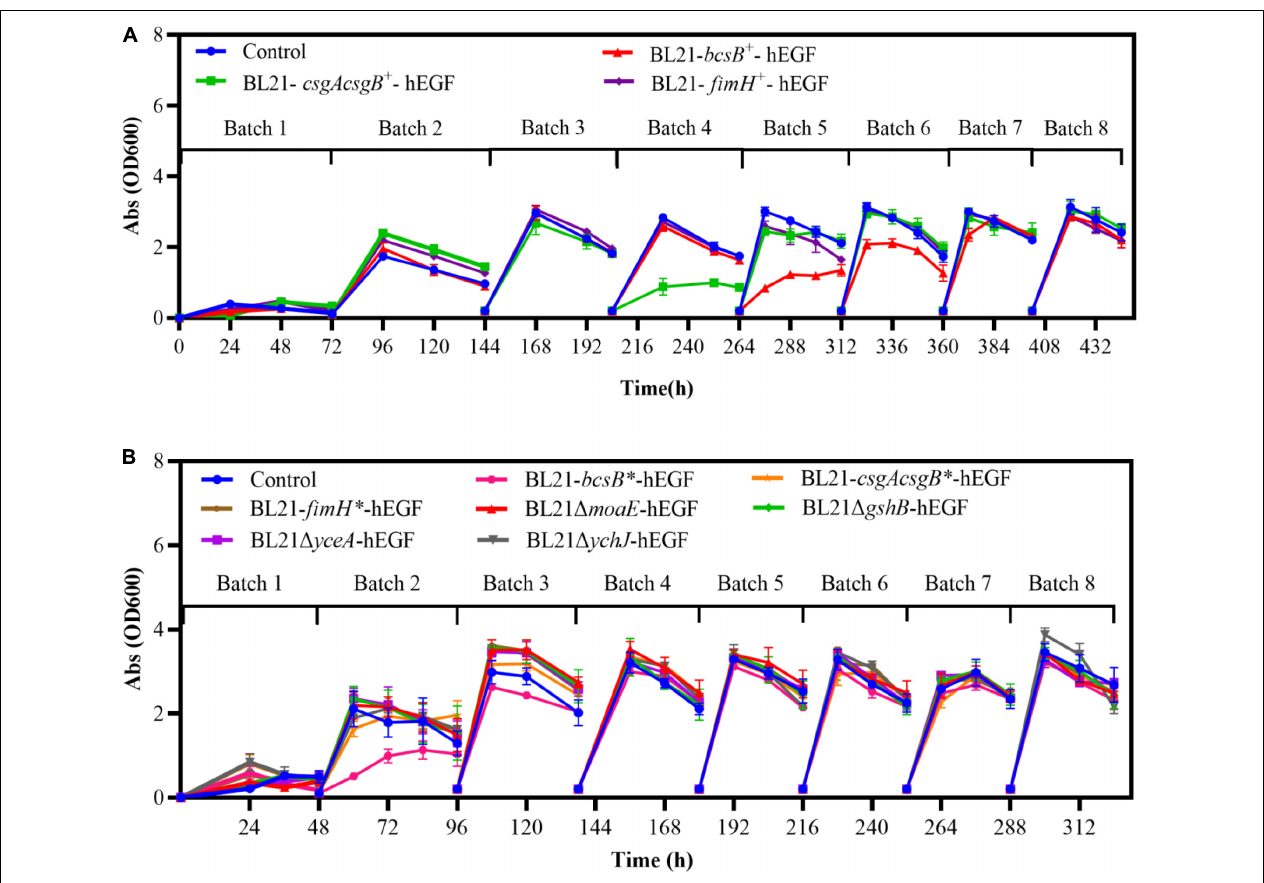
FIGURE 7 | Cell densities (OD 600 ) in the liquid cultures during biofilm-based repeated batch fermentation. (A) Strains with plasmid-based expression of biofilm related genes. (B) Strains with genome-integrated expression of or disruption of biofilm related